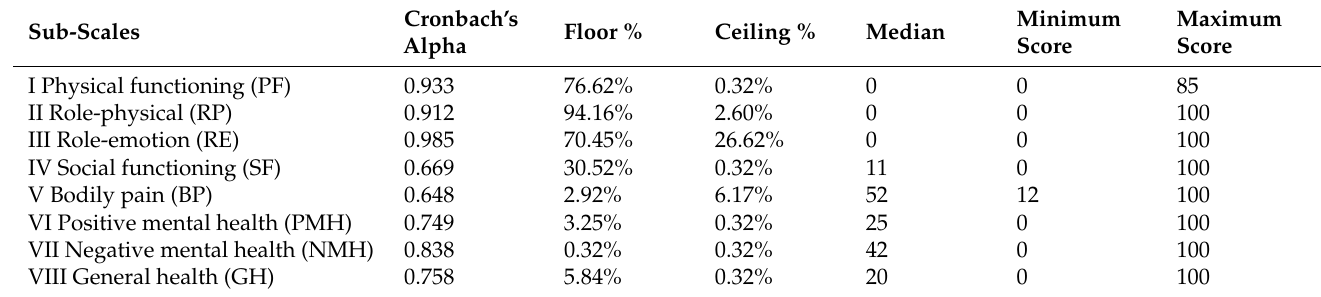
Table 3. Internal consistency, floor and ceiling effects of the SF-36.